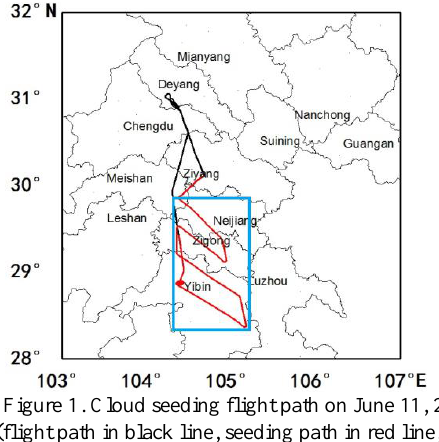
Figure 1. Cloud seeding flight path on June 11, 2018 (flight path in black line, seeding path in red line, seeding impact area in azure